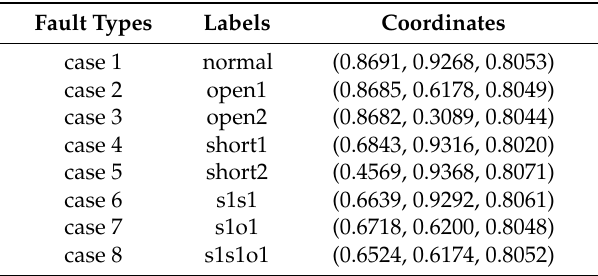
Figure 6. The training datasets and clustering center points of 8 faults. Table 4. Center-point coordinates of 8 clusterings in the reference fault datasets.